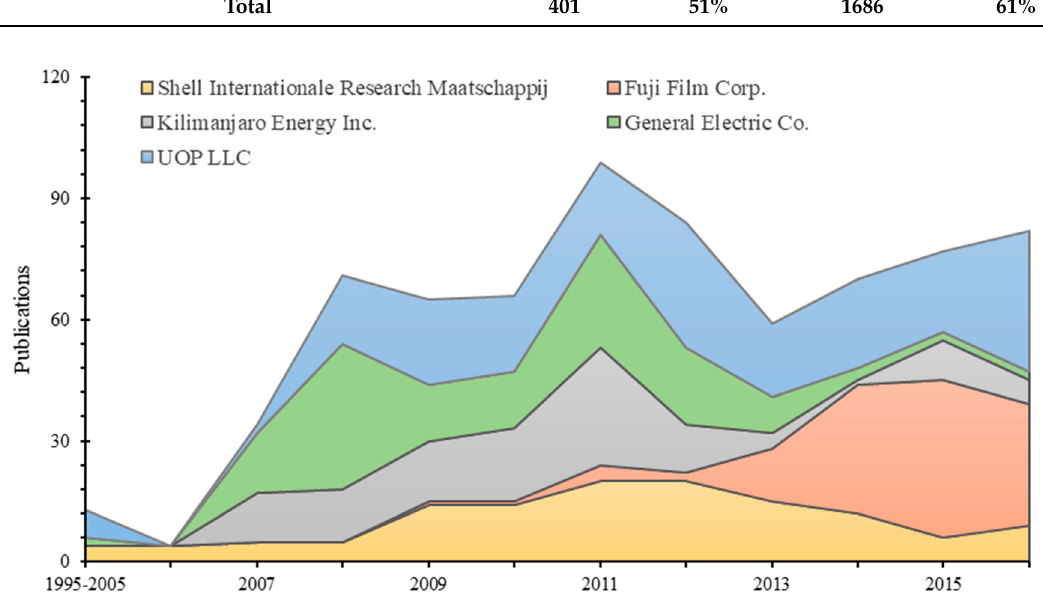
Figure 3. Evolution of the current top five patent-generator companies.